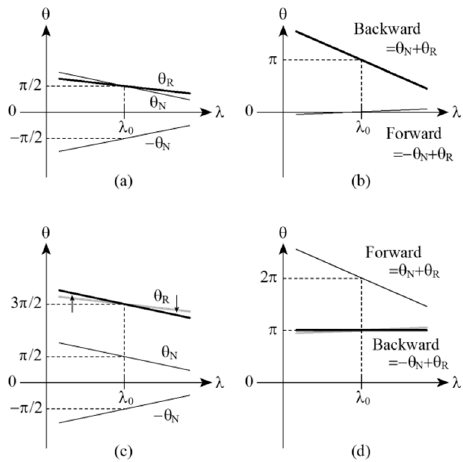
Figure 5. Wavelength dependence of nonreciprocal and reciprocal phase differences, θ N and θ R , respectively, of MZI isolator with ( a ), ( b ) conventional design and ( c ), ( d ) wideband design.